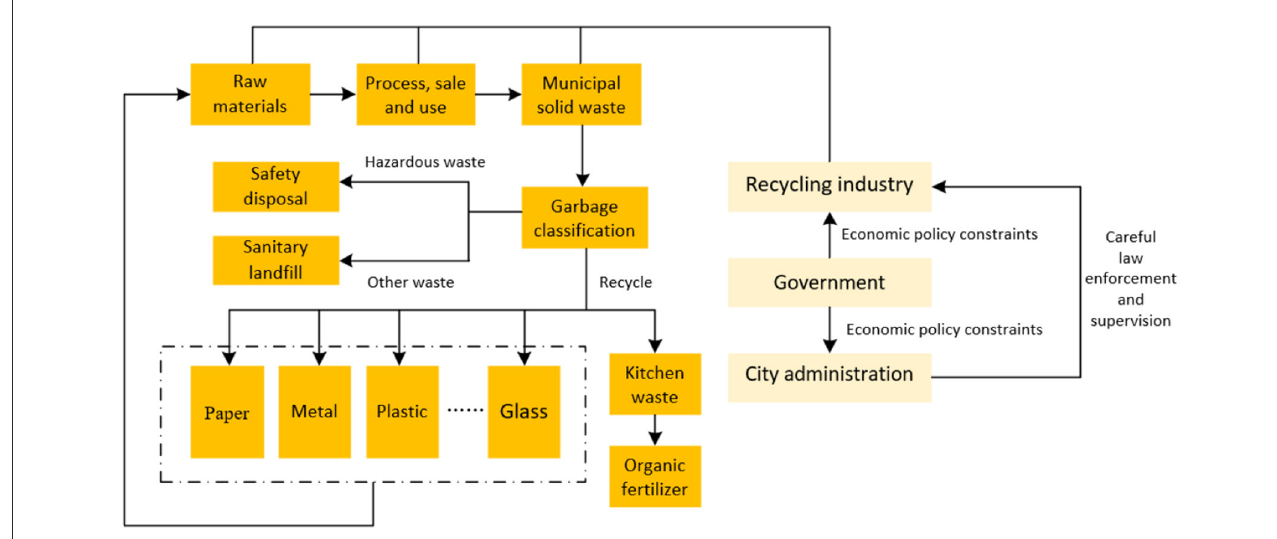
FIGURE1 The main process of municipal domestic waste recycling and related game